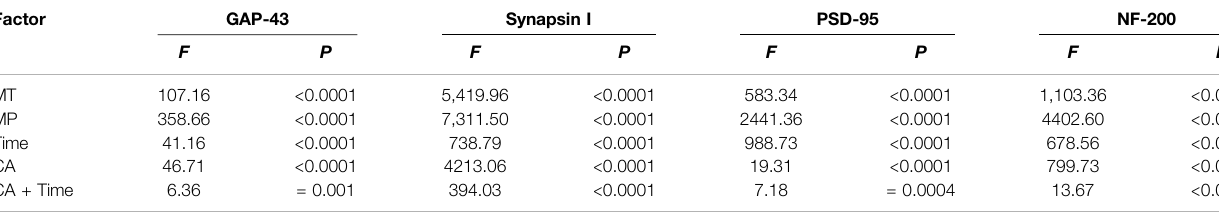
TABLE 2 | Main effects and interaction results of ANOVA of rat neurocritical proteins.